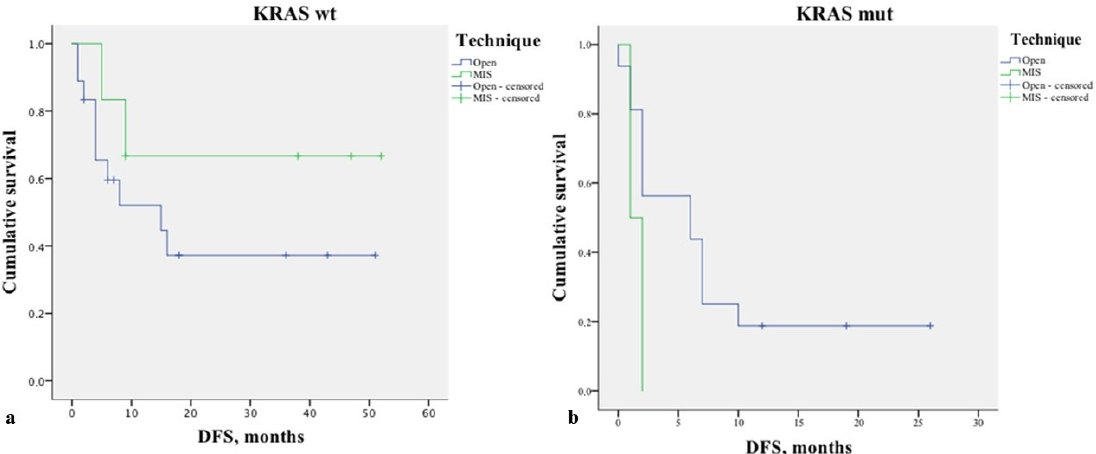
Figure 6. Kaplan–Meier curve of disease-free survival (DFS) ( p = 0.735) stratified by KRAS status. ( a ). KRAS wild type. Mean DFS rates for open surgery and MIS were 23.2 months ± 5.6 and 37 months ± 8.7, respectively; ( b ). KRAS mutation. Mean DFS rates for open surgery and MIS were 8.2 months ± 2.2 and 1.5 months ± 0.5,